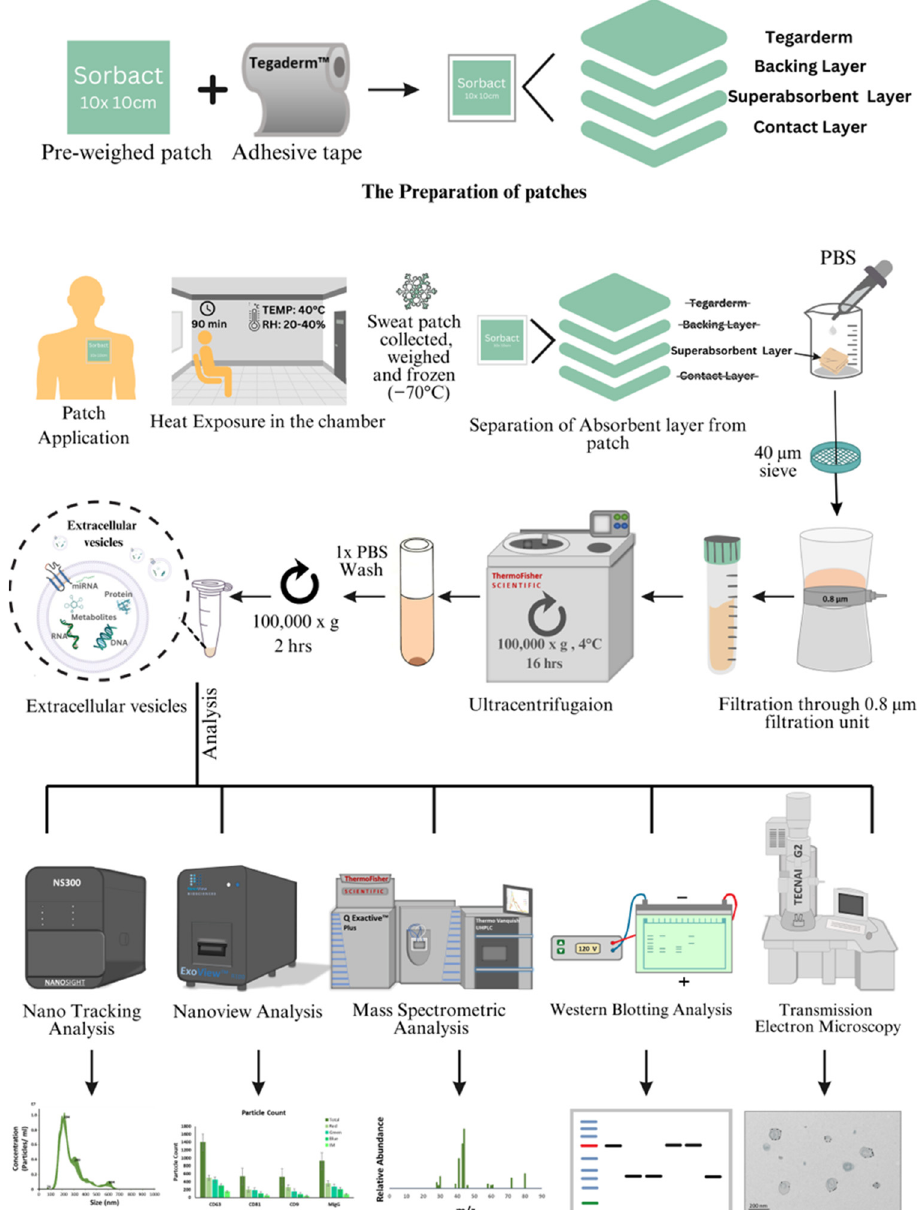
Figure 1. Experimental design. Detailed description of the study design and the sweat EVs’ isolation and characterization steps. RH: Relative Humidity. PBS: phosphate-buffered saline. min: minutes. hrs: hours.